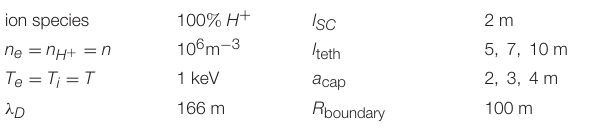
TABLE 1 | Physical and simulation parameters considered in the simulations. TABLE 2 | Steady state currents collected by the spacecraft and the tethered capacitor for the different configurations